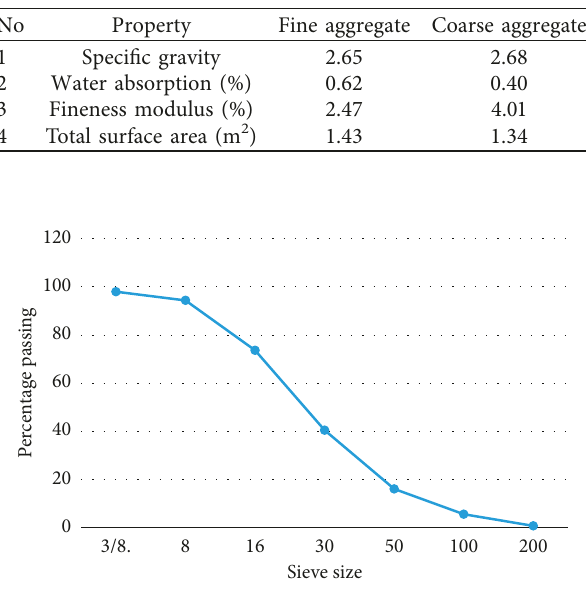
Figure 1: Grain size distribution of fine and coarse aggregate.